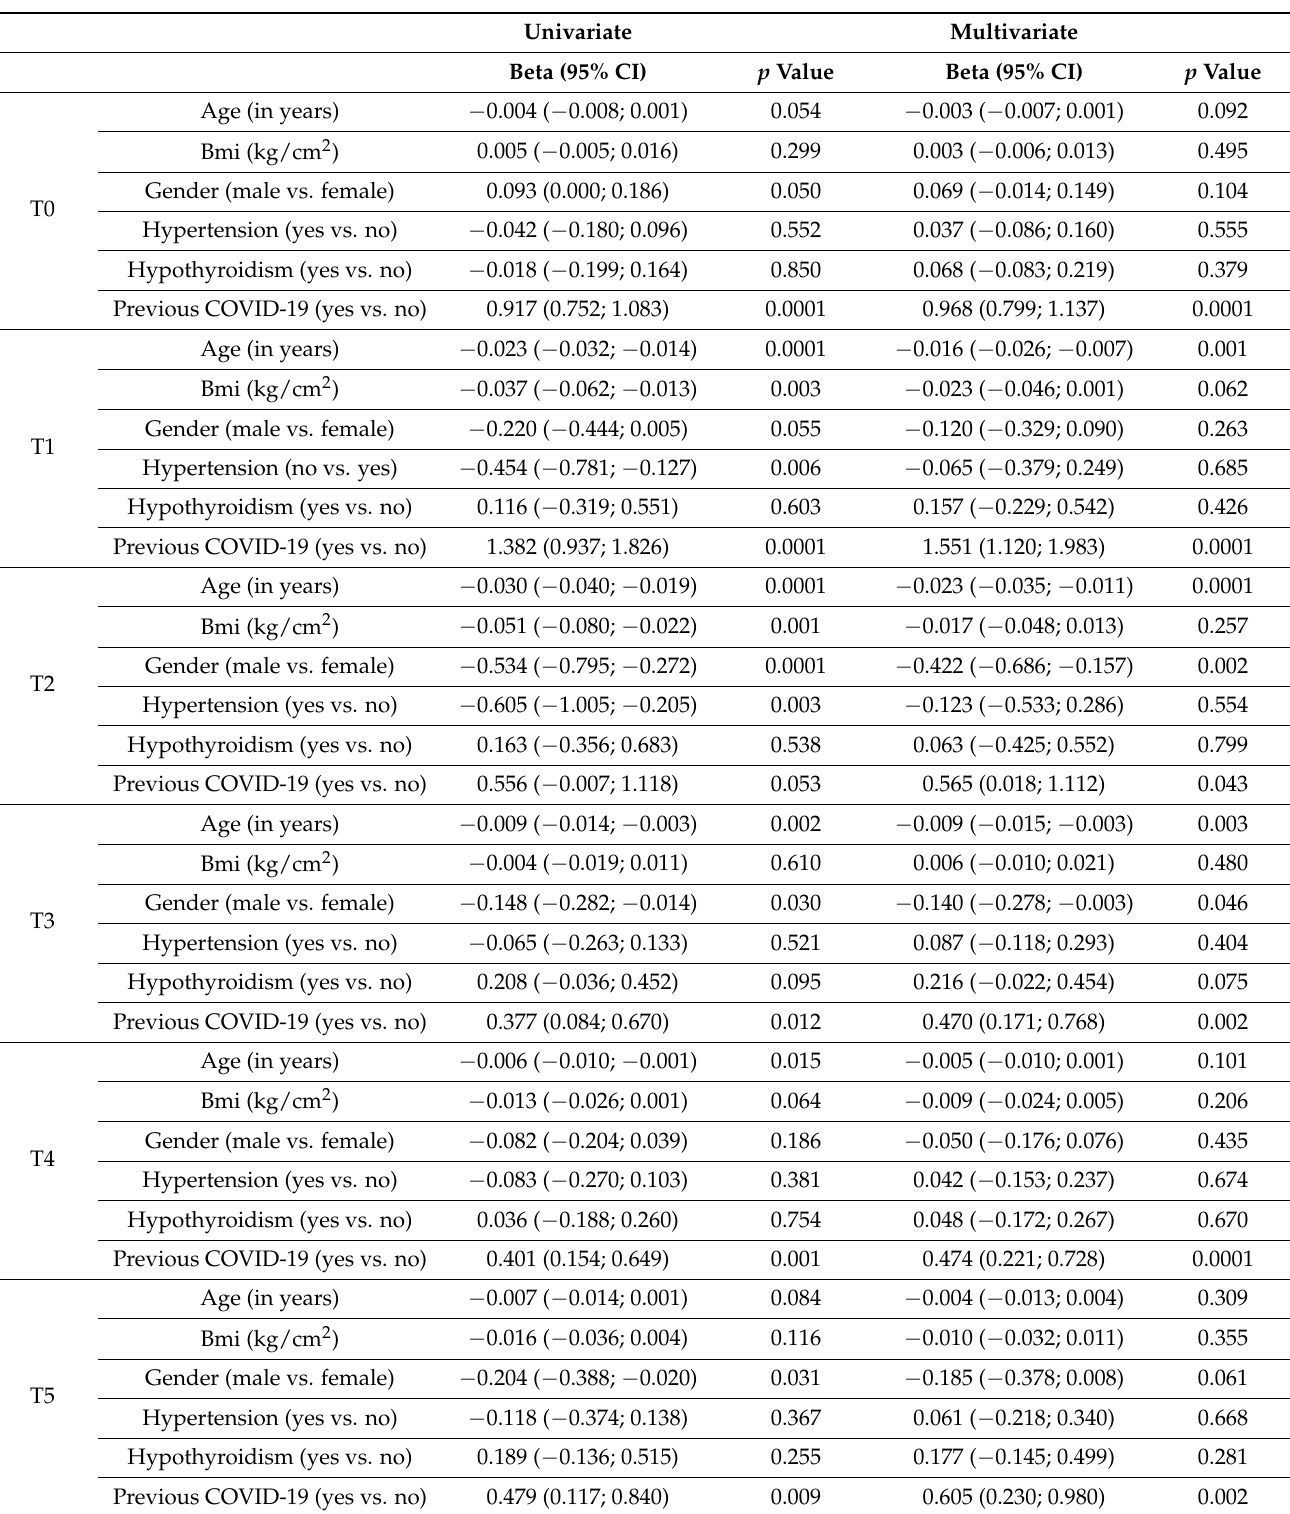
Table 3. Univariate and multivariate linear regression of antibody levels (AU/mL) by age, BMI, gender, hypertension, hypothyroidism, and previous